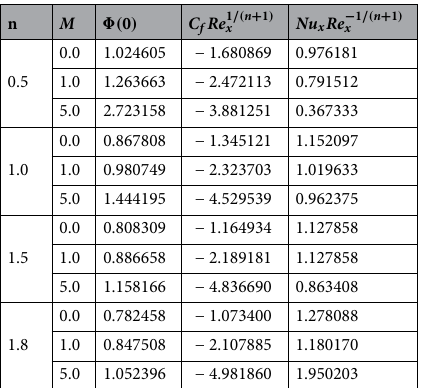
1 /( n + 1 ) x and Nusselt number Nu x Re